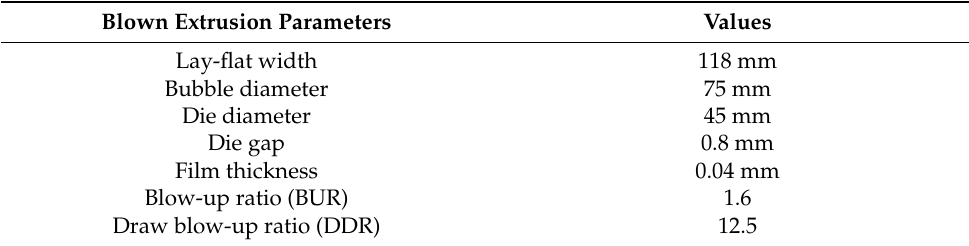
Table 3. Blown extrusion